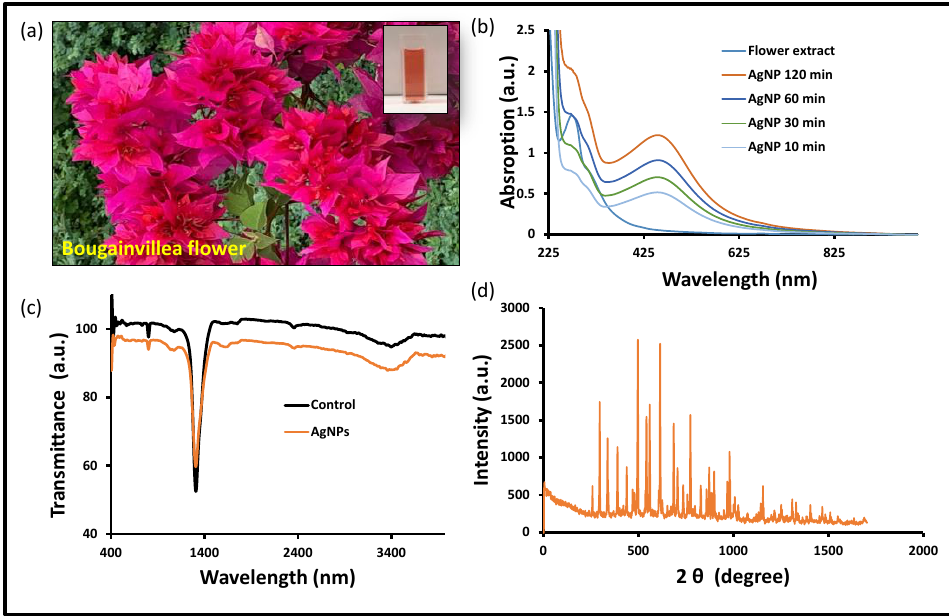
Figure 1. Biogenic AgNPs’ characterization: ( a ) Bougainvillea flower and extract in cuvette, ( b ) UV-vis spectra, ( c ) FTIR spectra, and ( d ) XRD spectra at 2 ϕ (degree) of BAgNPs. Table 1. The comparative chart of Bougainvillea plant extract-based materials’ synthesis and biological